Question: Does the plotted quantity increase or decrease?
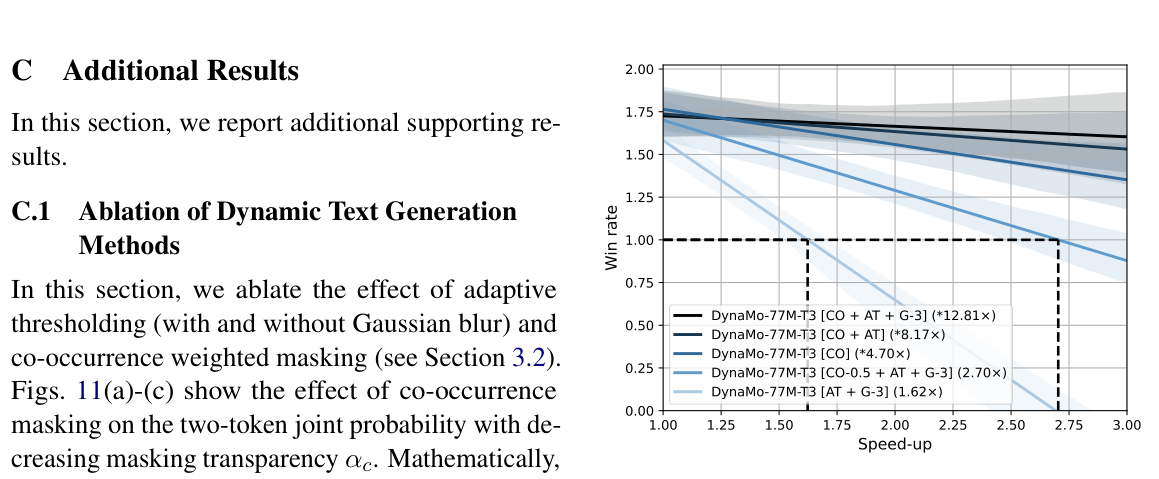
Answer: increasing